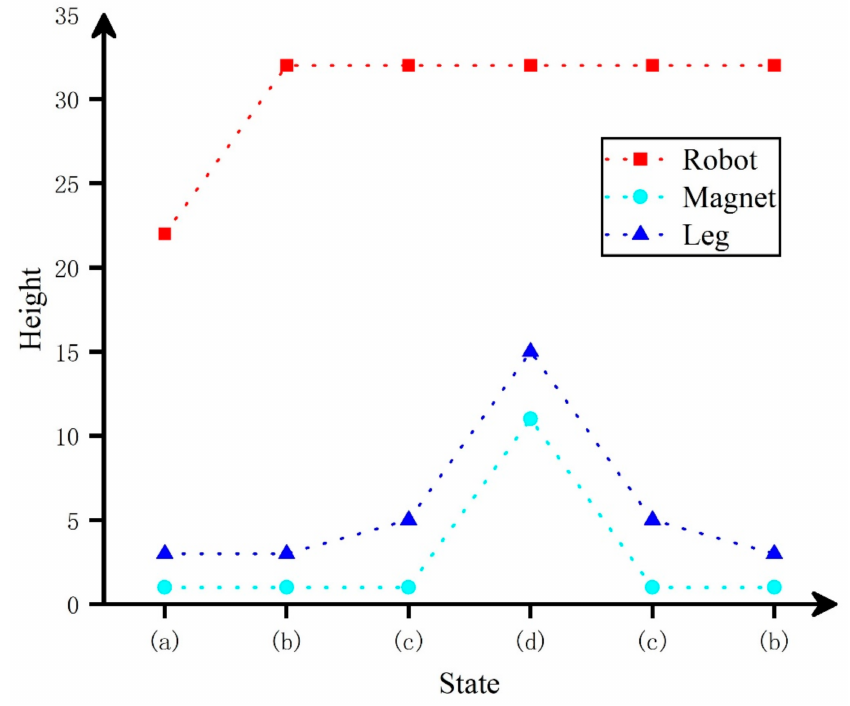
Figure 8. Height control curve.